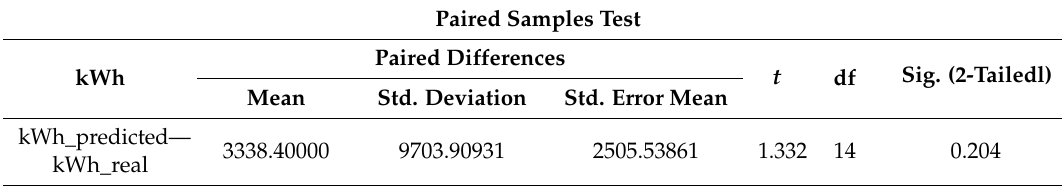
Table 11. Paired samples test D3